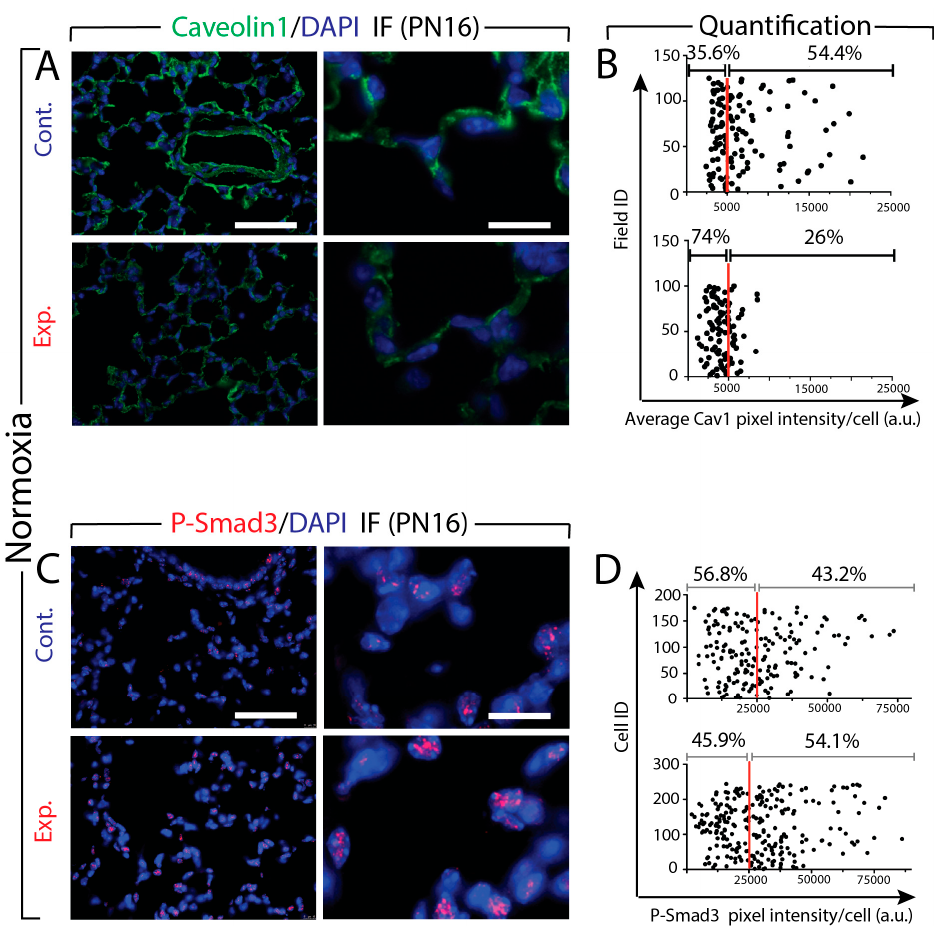
Figure 5. Expression of Cav1 and P-Smad3 proteins in the lung tissues from control (Cont.) and experimental (Exp.) mice at P16 under NOX condition. A . IF images show a decreased expression of Cav1 in the experimental lungs. B . Quantification of pixel intensity of Cav1 positive cells indicates a significant decrease of Cav1 expression in the experimental mice. C . The IF images show an increased expression of P-Smad3 in the experimental lungs. D . Quantification of pixel intensity of P-Smad3 positive cells supports the IF images in C . Scale bar A and C : low magnification: 180 μ m; high magnification: 45 μ m.